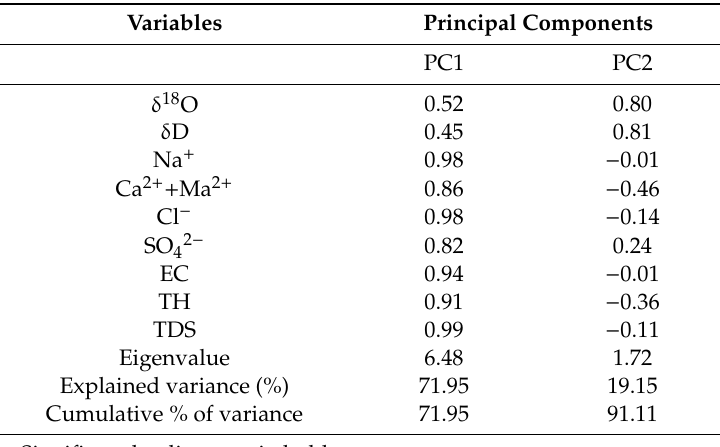
Table 2. Component loadings by PCA (principal component analysis) for all water samples from the Sanshandao deposit ( n =